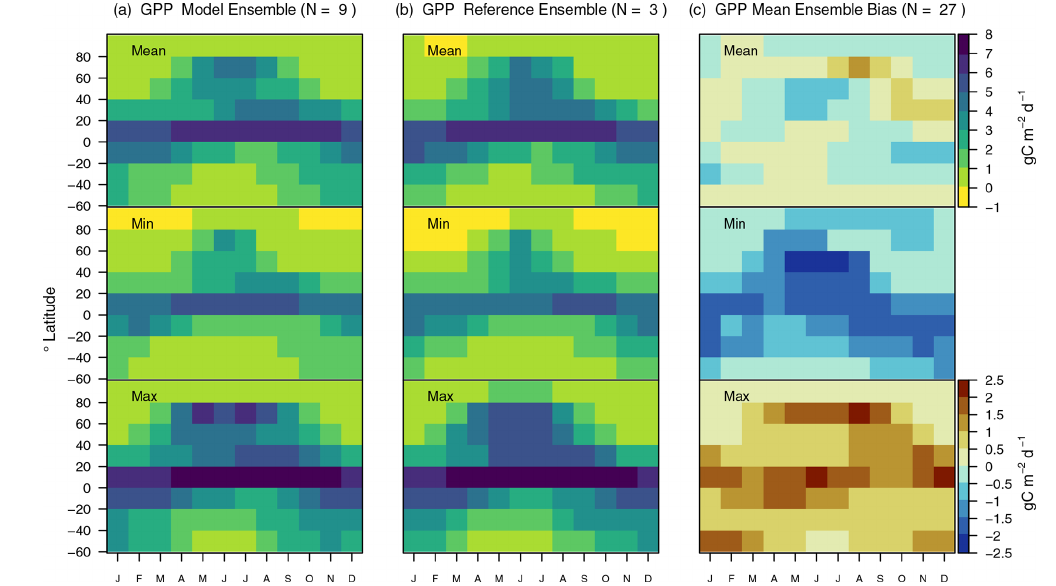
Figure A17. Same as in Fig. 8 but for gross primary